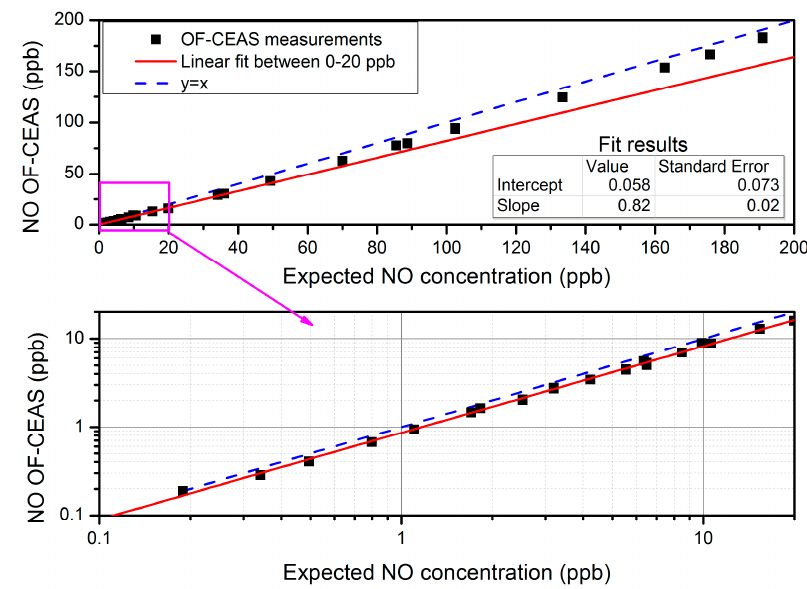
Figure 6. Preliminary to the correction of the optical saturation effect: Concentration given by the analyzer (NO OF-CEAS) versus the expected concentration from the dilution factor of a calibrated tank. The red line is a linear fit of the measurements between 0 and 20 ppb (shown in log-log scales in the bottom zoom for more clarity). Pressure in the cavity is regulated to 107 mbar.